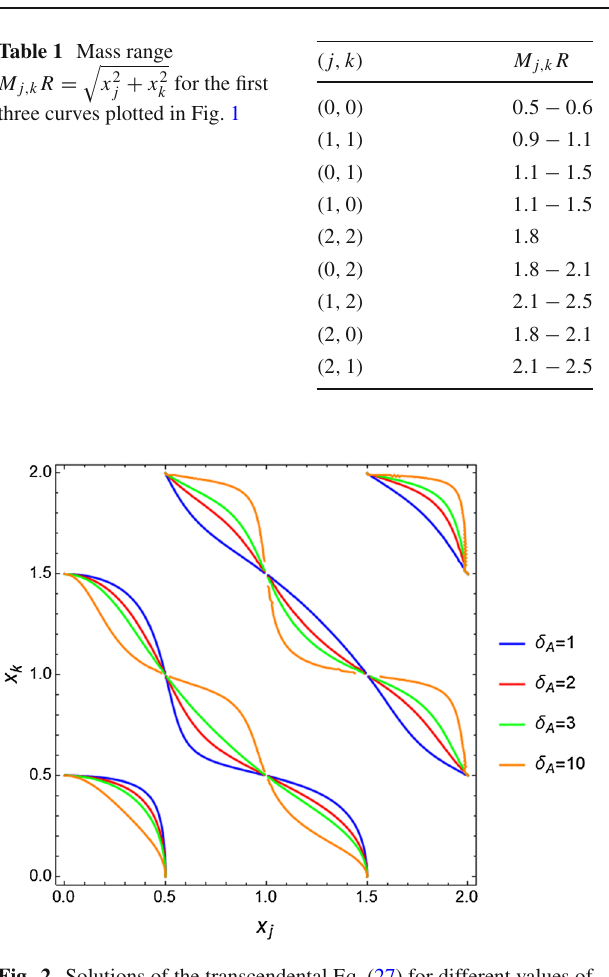
Fig. 2 Solutions of the transcendental Eq. (27) for different values of δ A , for the thin-brane model